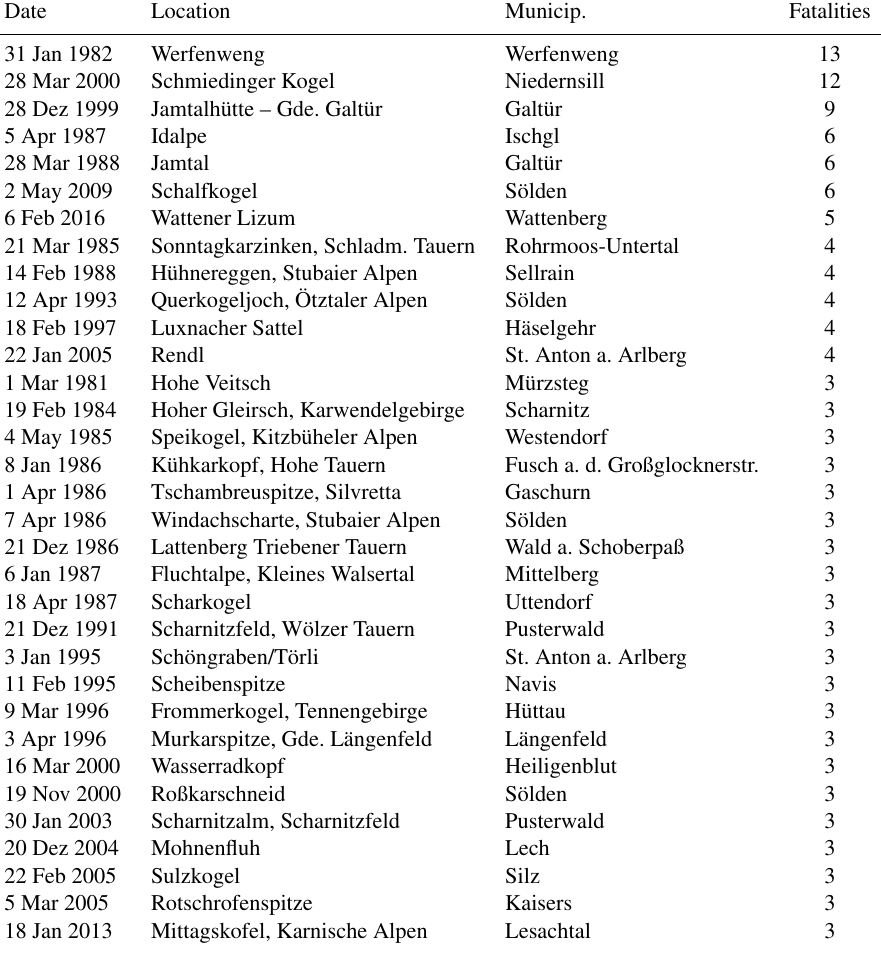
Table 4. List of avalanche events (off-piste or backcountry) in Austria within 1980/1981–2015/2016 with more than two fatalities in each